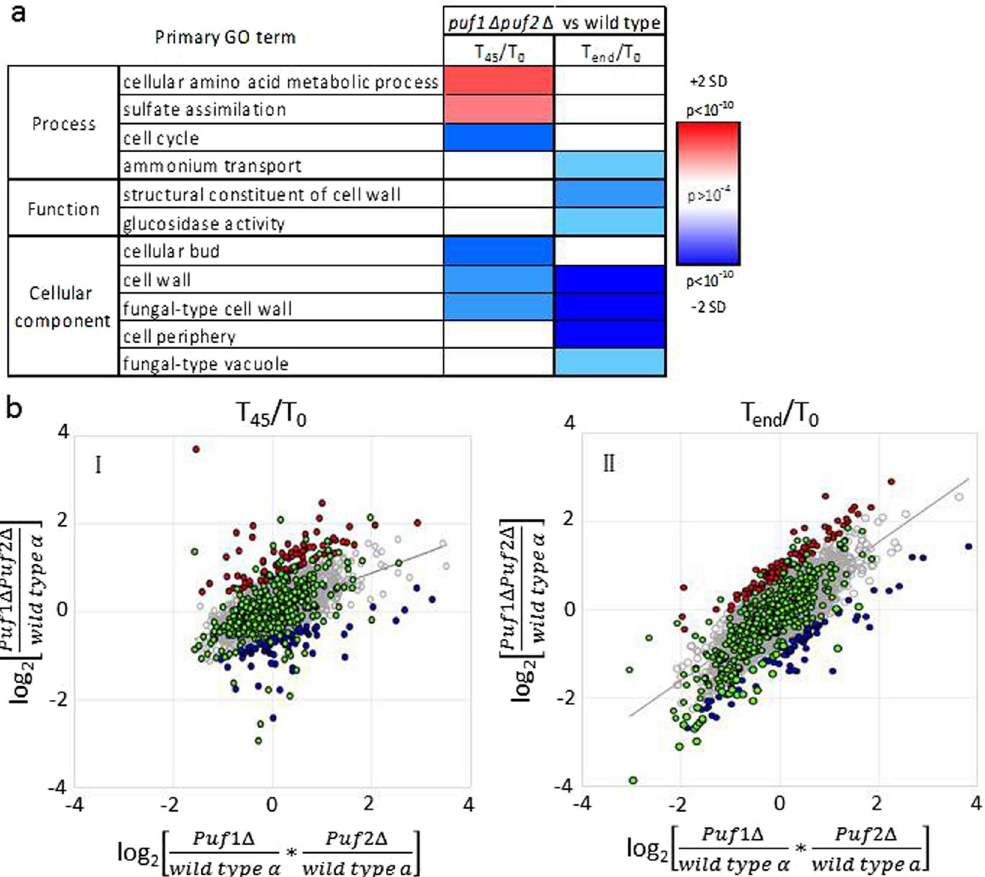
Figure 7. Effect of Puf1 and Puf2 double deletion. ( a ) Heatmap of SGD GO enrichment analysis of significantly affected genes in T 45 /T 0 and T end /T 0 in puf1 ∆ puf2 ∆ relative to wild-type α . The red or blue shades indicate levels of enrichment score of induced or repressed respectively, and the color intensity indicates the level of p value enrichment score of each GO term. Only primary GO terms with p value < 10e − 4 and FDR ≤ 0.01 are presented. ( b ) Scatterplots of log 2 normalized reads of puf1 Δ puf2 Δ /WT α against multiplication of puf1 Δ /WT α and puf2 Δ / WT ‘a’ in T 45 /T 0 (I) and T end /T 0 (II). Genes significantly affected by the synergism of Puf1 and Puf2 knockouts are colored in red (two standard deviations above the trend line) or in blue (two standard deviations below the trend line). Genes bound by Puf1 or Puf2 13, 15 within the two standard deviations areas are colored in